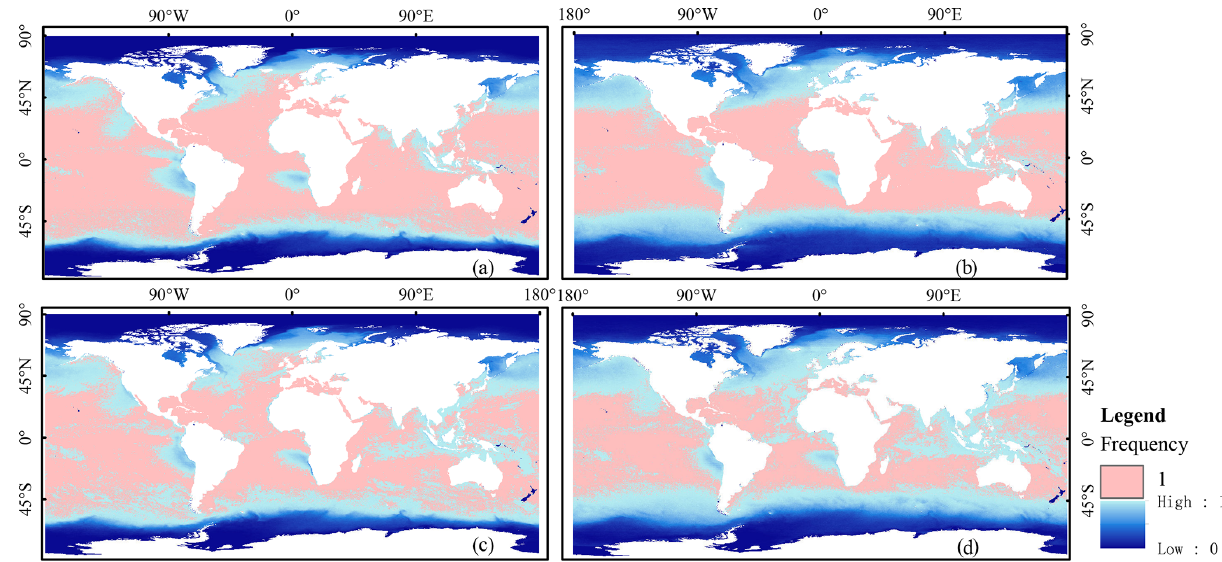
Figure 7. Frequency of non-null pixels, including valid pixels and low-quality pixels, in the monthly MODIS SST data during the study period from (a) nighttime Aqua overpasses, (b) daytime Aqua overpasses, (c) nighttime Terra overpasses, and (d) daytime Terra overpasses.